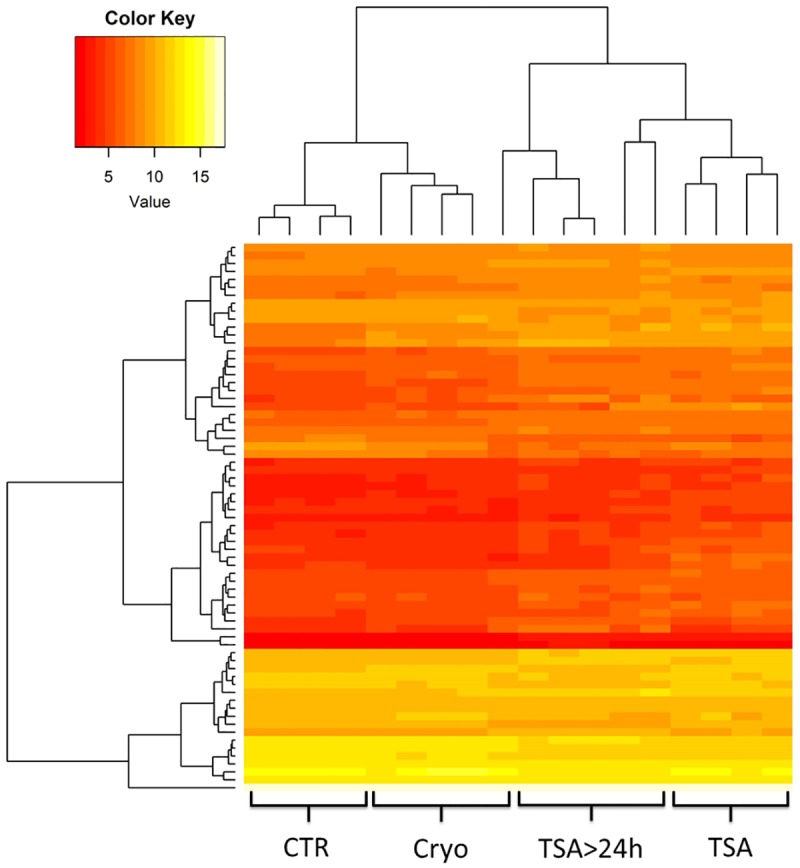
Hierarchical clustering of expression profiles of all studied cultures based on genes with the highest differentiation among the groups.CTR–fresh (not cryopreserved) controlCryo–cryopreserved, not treated cellsTSA–cells treated with TSA for 24hTSA>24h –cells treated with TSA for 24h and further cultured following TSA removal.